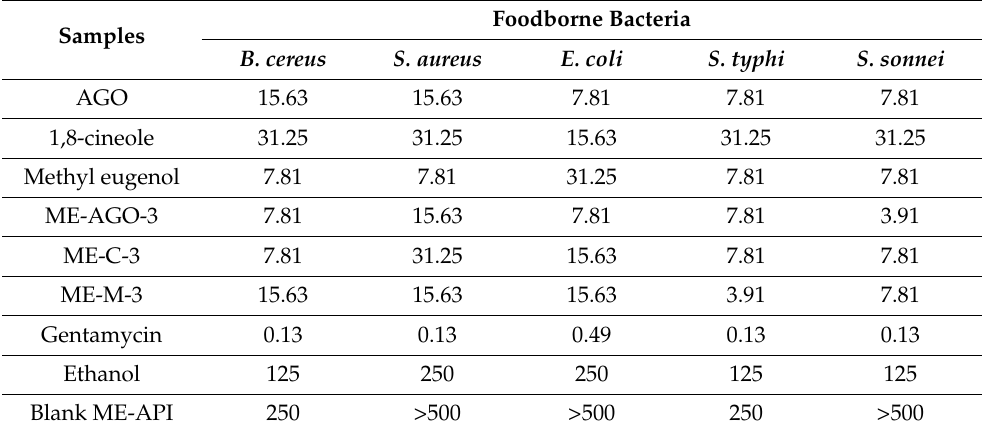
Table 3. Minimum bactericidal concentrations (MBCs) ( µ g/mL) of 30% w / w AGO in ethanol,